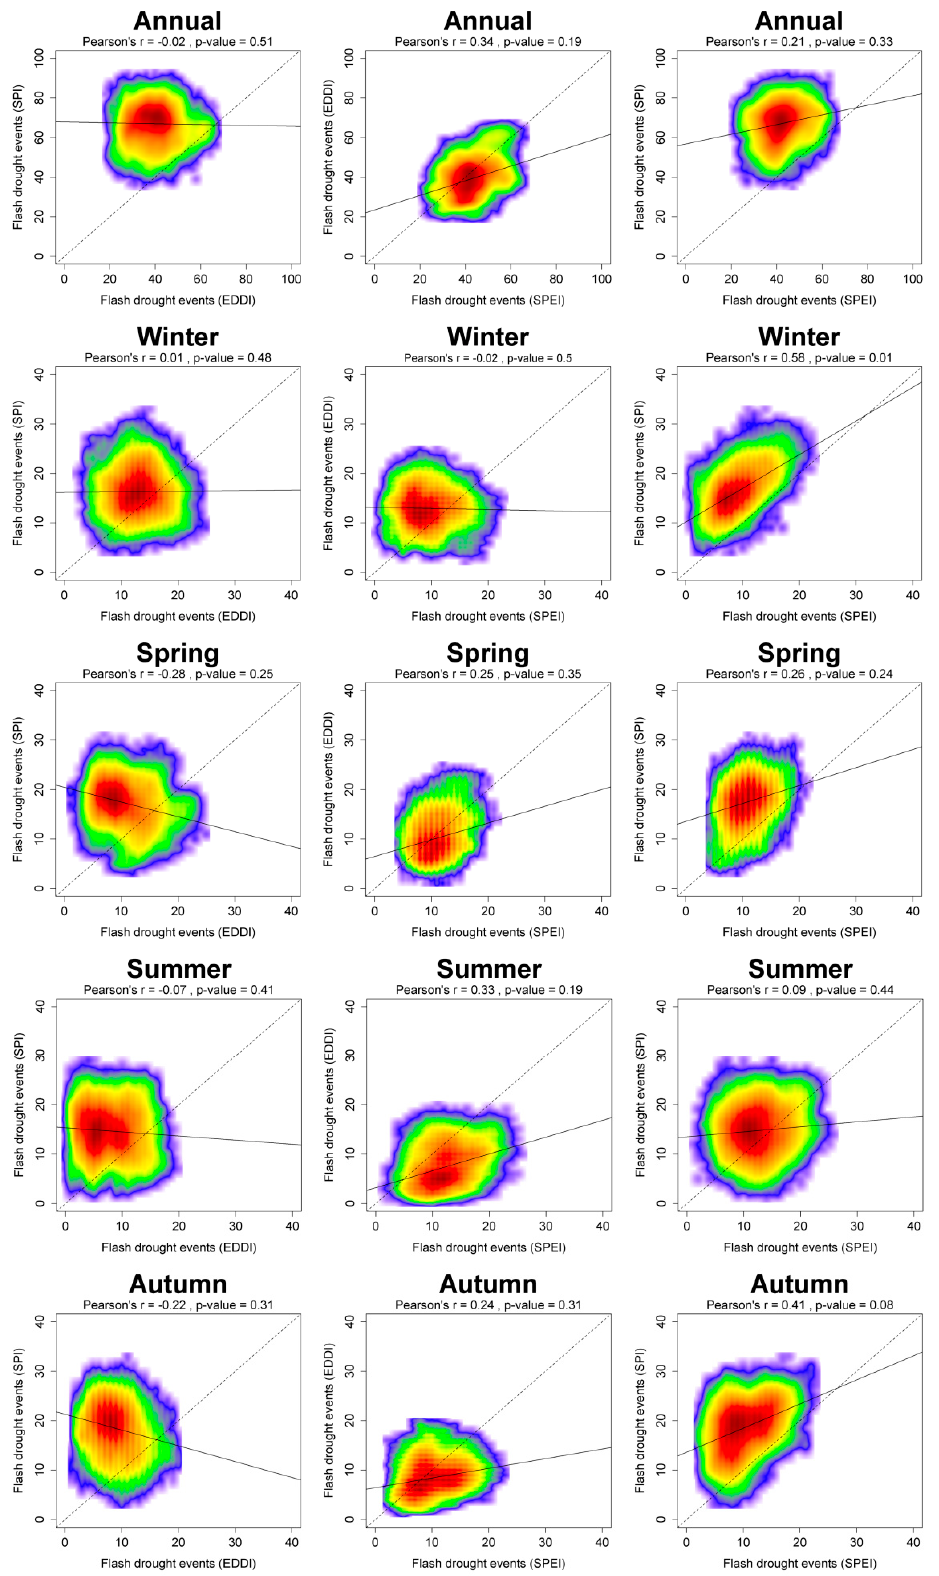
Figure 4. Scatterplots showing the annual and seasonal relationship between the total number of flash drought events recorded by the SPI, EDDI, and SPEI. The colors represent the density of points, with red denoting the highest density.